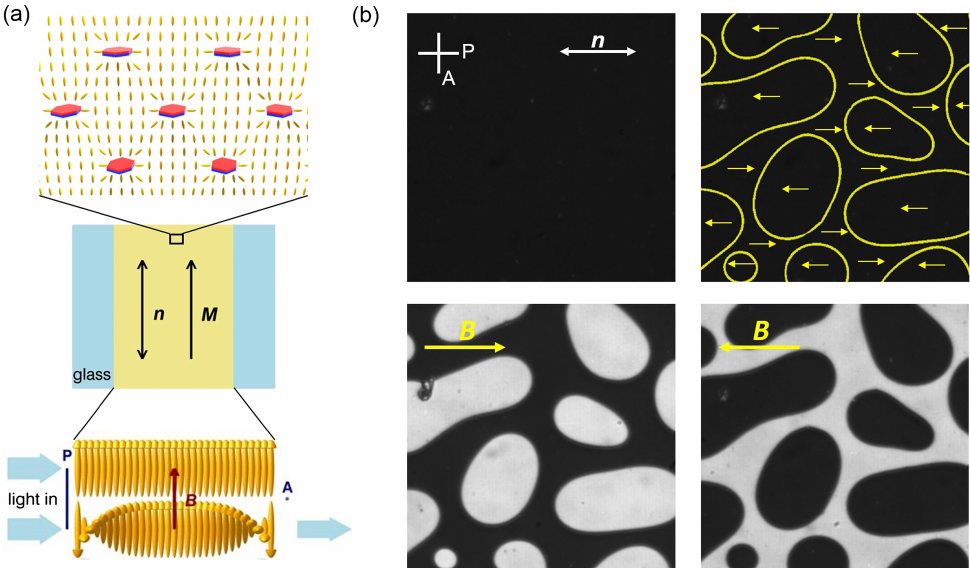
Figure 10. Ferromagnetic suspension of Ba hexaferrite nanoplates in NLC: ( a ) Magnetic nanoplates (red and blue) orient with their magnetic moments along the average order of liquid-crystal molecules (yellow ellipsoids). ( b ) Polarized-light microscopy images of two types of antiparallel magnetic domains form with the magnetization along the NLC orientation (denoted by n ). P and A indicate the orientation of the polarizer and analyzer, respectively. The upper images show the suspension in the absence of the field; in the right-hand side image, the domain walls are drawn. The bottom images show the response of the domains to a magnetic field. The image is reprinted and adapted with permission from the reference [151]–Copyright (2018) Elsevier